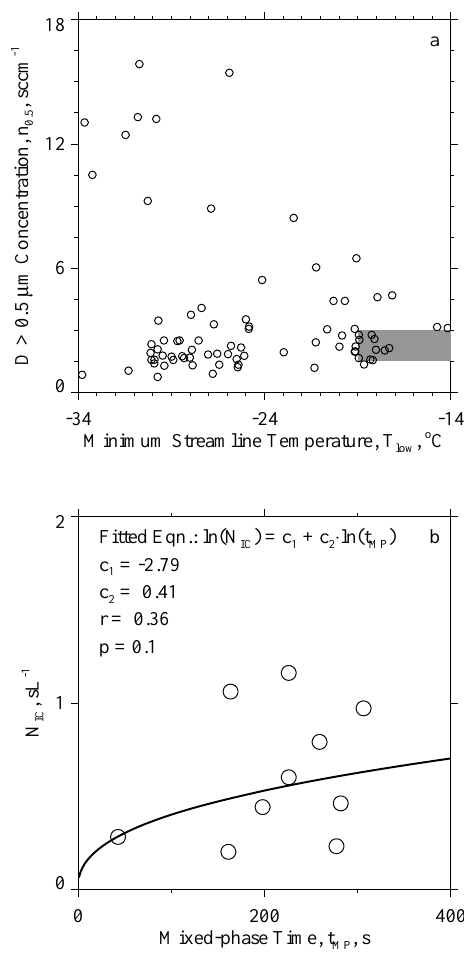
Figure 4. (a) The 80 paired values of n 0 . 5 and t MP in our data set. The gray rectangle highlights the 10 points in the subset defined by − 19 ≤ T low < − 14 ◦ C and 1.5 ≤ n 0 . 5 < 3 . 0sccm − 1 . (b) The 10 paired values of N IC and t MP from the gray rectangle shown in Fig. 4a. The black line is the fitting equation ln (N IC ) = c 1 + c 2 · ln (t MP ) . The Pearson correlation coefficient ( r) and the level of significance ( p) were evaluated using the log-transformed concen- trations and log-transformed mixed-phase